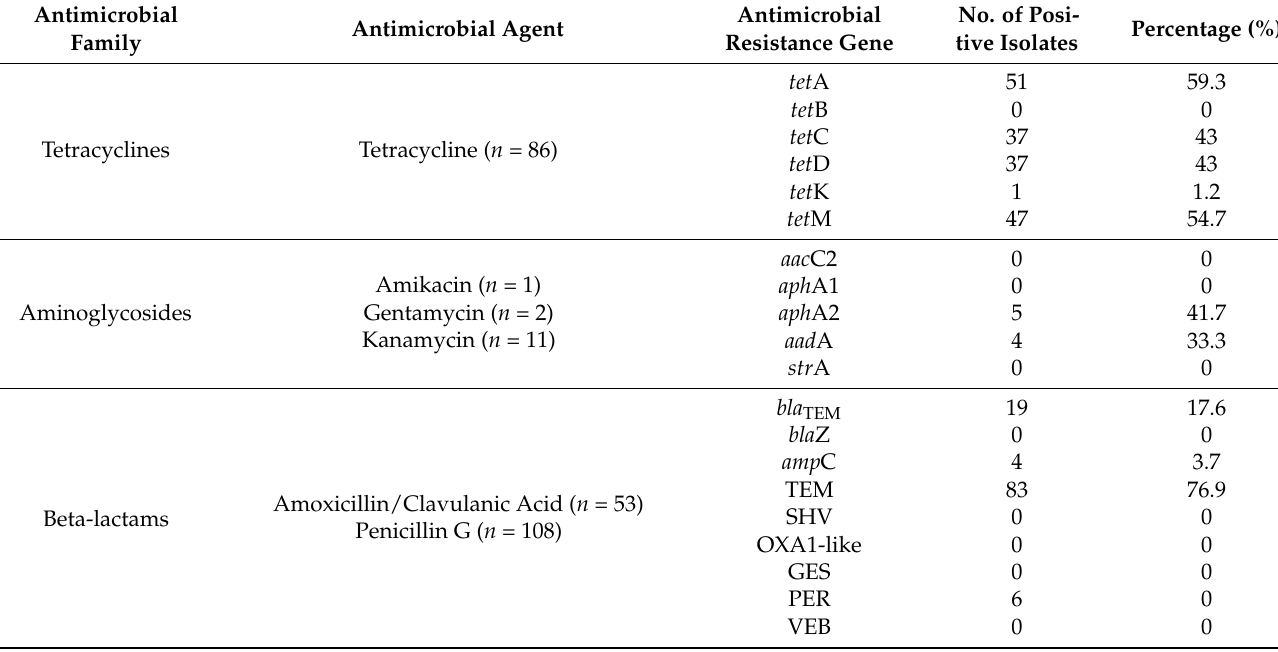
Table 2. Frequency of antimicrobial resistance gene subtypes in L. monocytogenes